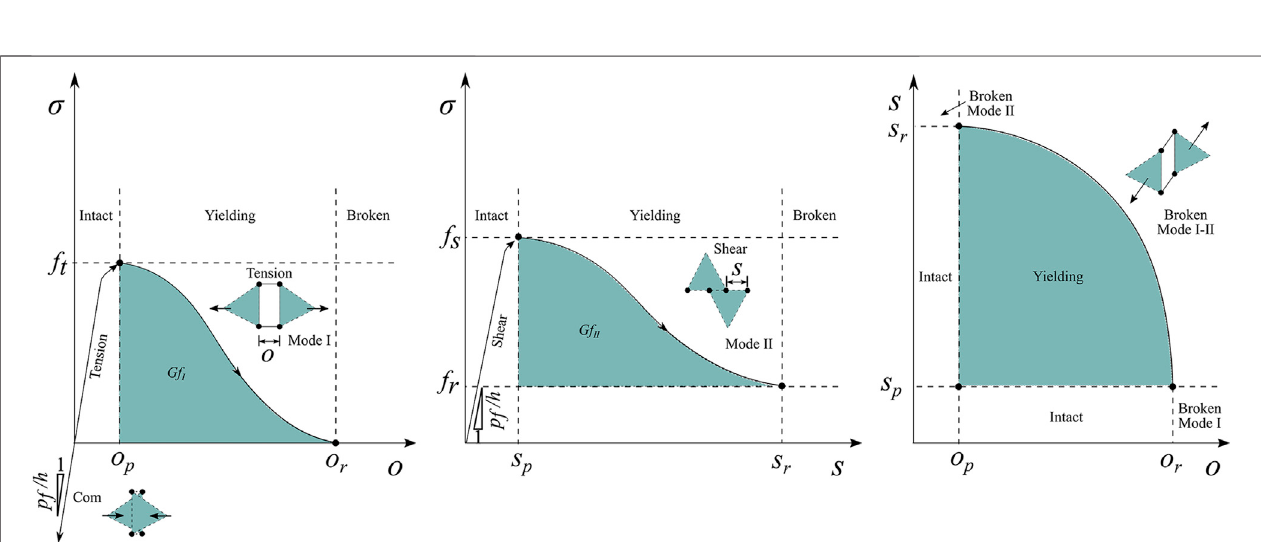
FIGURE 4 | The failure modes in FDEM. (A) Mode I tensile failure; (B) Mode II shear failure; (C) mixed Mode I-II